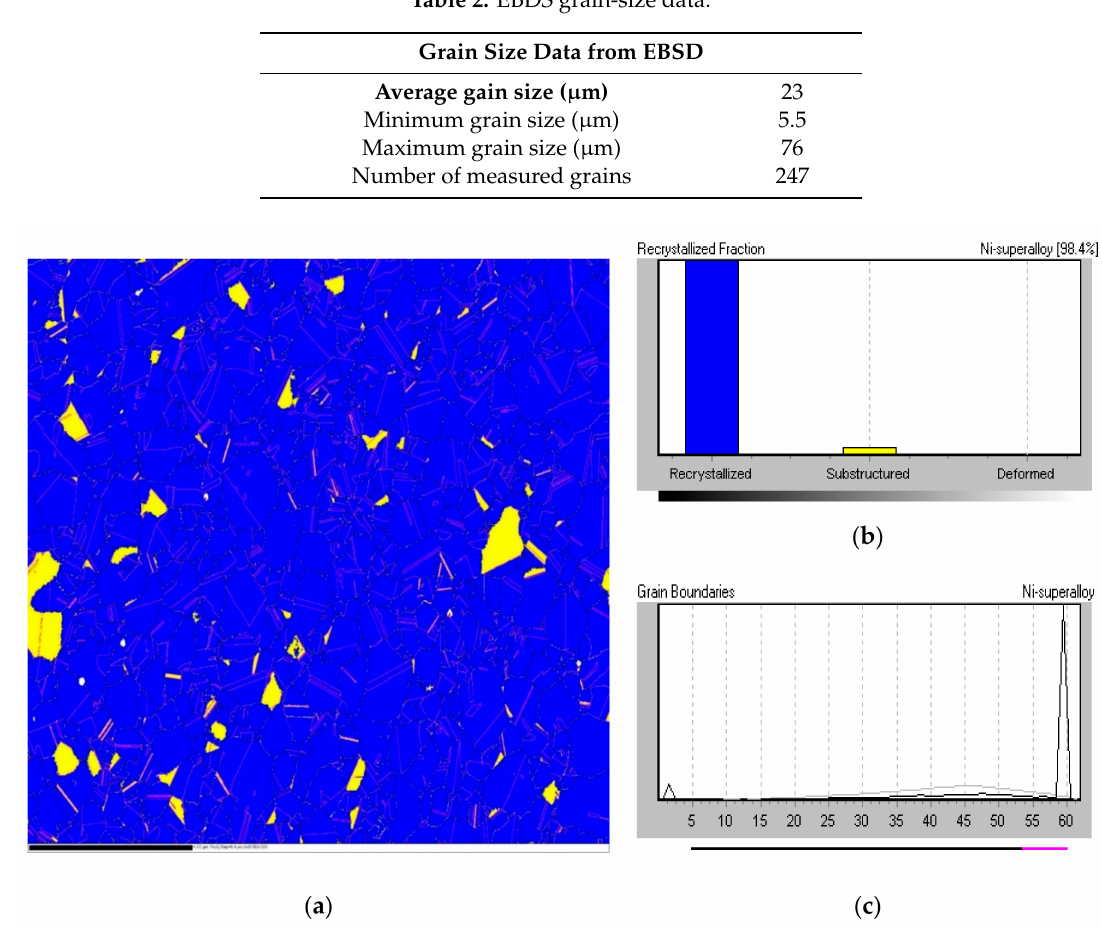
Figure 4. Electron backscatter di ff raction (EBSD) data for, ( a ) image of recrystallization fraction of, ( b ) graph of recrystallization fraction of, and ( c ) grain boundaries within as-received base